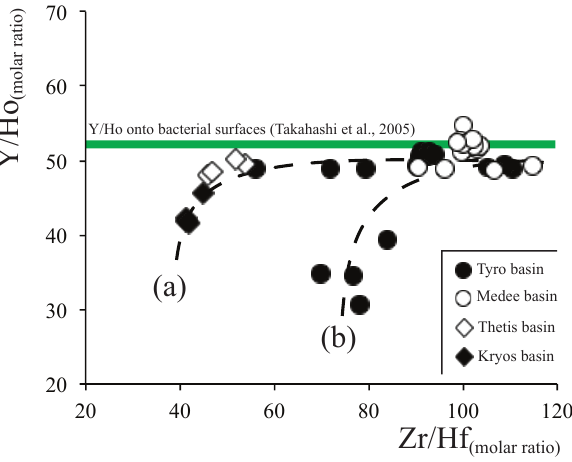
Fig. 7. Shale-normalised REE distributions in selected kainite Fig. 7 – Shale normalised REE distributions in selected kainite (MgSO 4 · KCl · 3H 2 O) (dashed 638 (MgSO 4 · KCl · 3H 2 O) (dashed curves) and sylvite (KCl) (solid curves) and sylvite (KCl) (full curves) samples. Data from Ragusa (2013). 639 curves) samples. Data from Ragusa (2013).